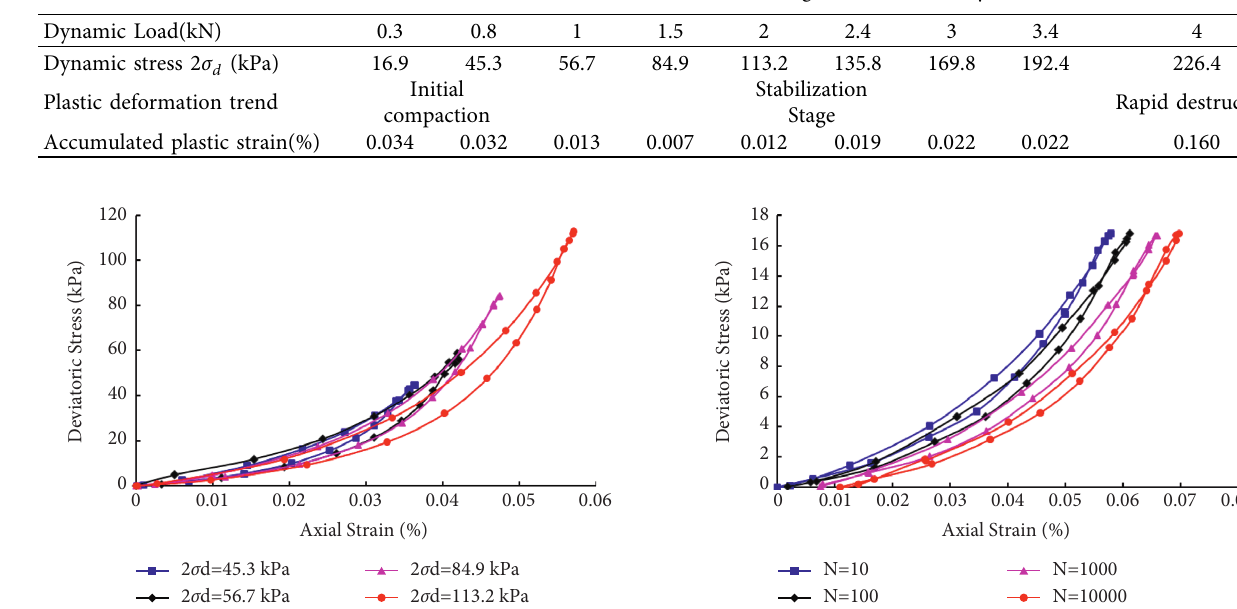
Table 2: Plastic cumulative deformation characteristics of filling under different dynamic